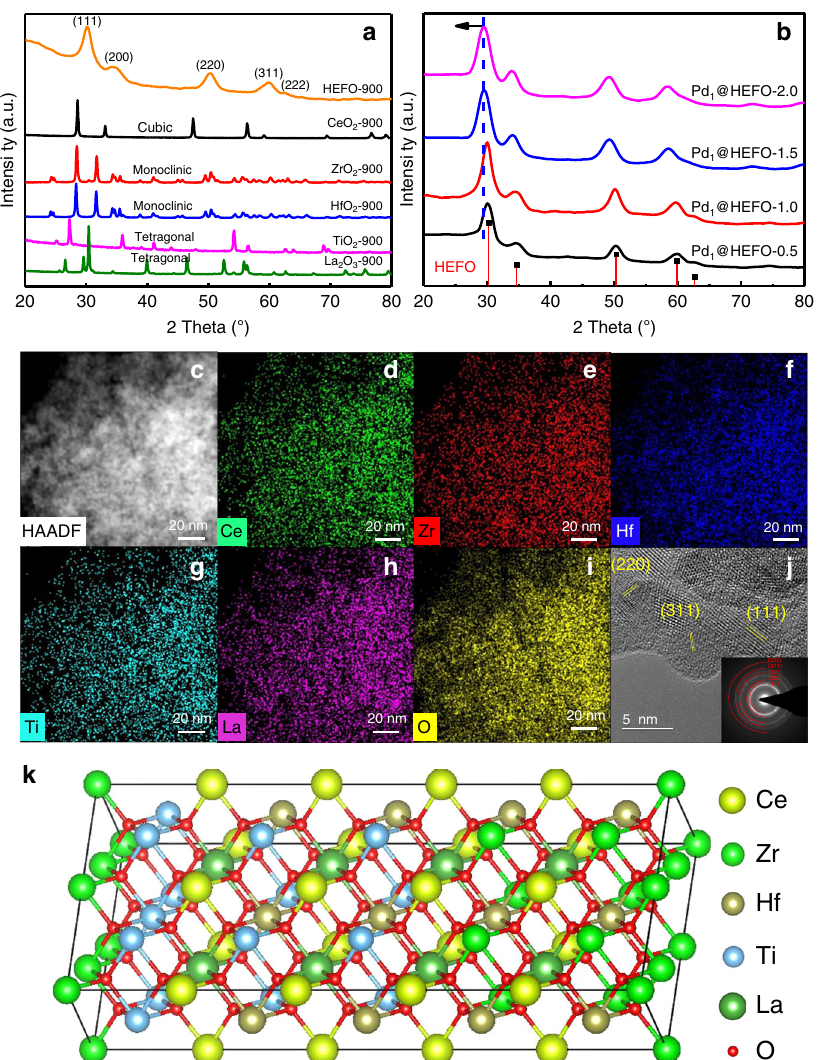
Fig. 2 Structural characterizations of HEFO and Pd 1 @HEFO catalyst. a PXRD patterns of HEFO, CeO 2 , ZrO 2 , HfO 2 , TiO 2 , and La 2 O 3 pyrolyzed at 900 °C. b PXRD patterns of Pd 1 @HEFO- x samples ( x is the Pd weight loading). c EDS mapping of d Ce, e Zr, f Hf, g Ti, h La, and i O for HEFO. j HRTEM image and corresponding FFT pattern (inset) of HEFO. k Schematic model of HEFO. Source data are provided as a Source data fi